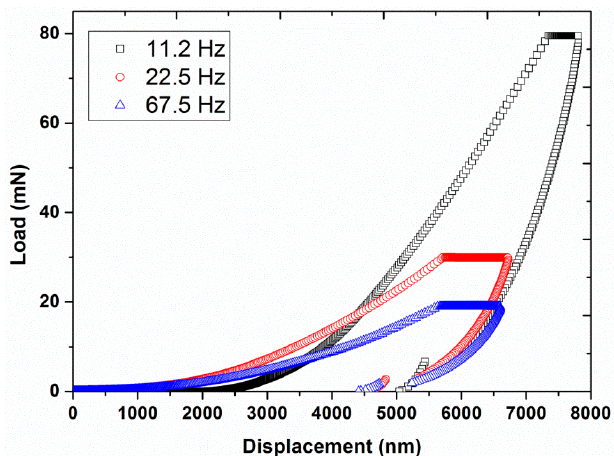
Figure 4. Indentation load required to yield various displacements for the three different frequencies (11.2, 22.5, and 67.5 Hz) at a vibration amplitude of 2 nm and strain rate of 0.05 s − 1.